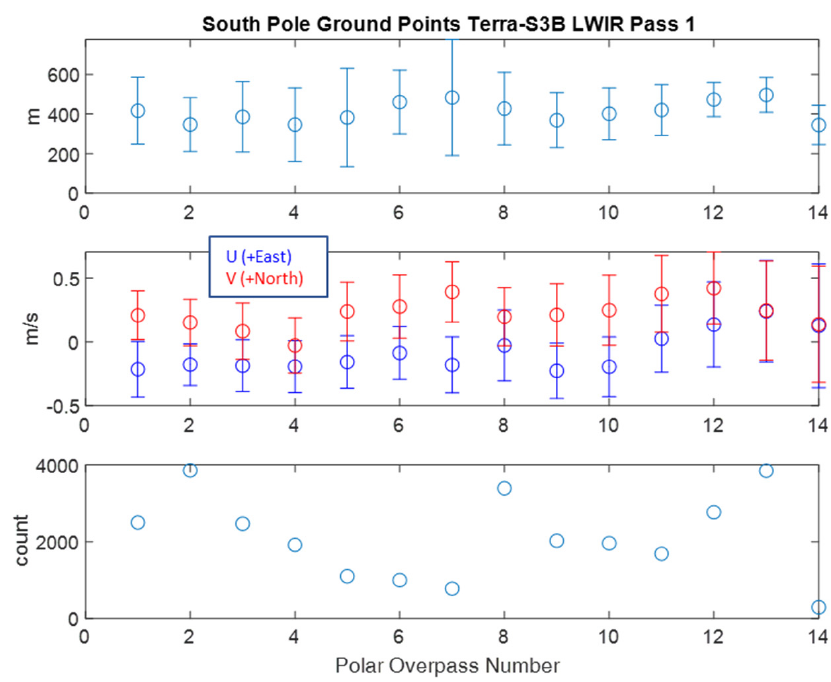
Figure 7. Ground-point retrieval statistics for 14 Antarctic overpasses on 21 December 2021 show biases in the retrieved heights and speeds for each overpass. The coordinate directions ( u , v ) are oriented along the cardinal directions and remain well-defined as the swaths never include the exact location of either North or South Pole.